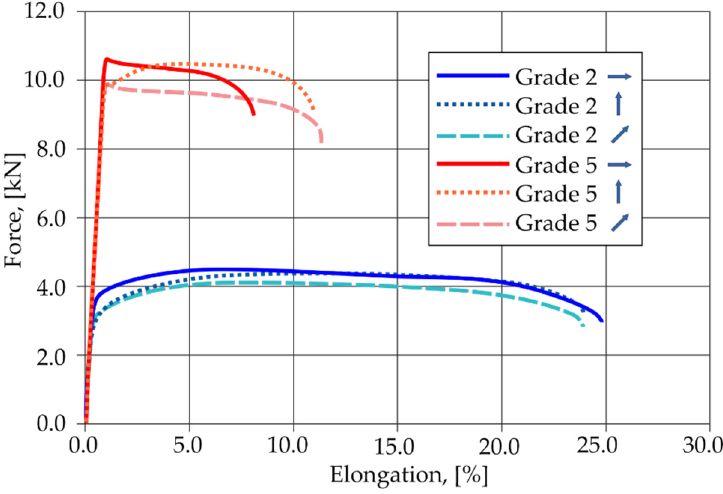
Figure 7. The method of failure of titanium samples in a tensile shear test: ( a ) with a single weld— Gr5–Gr5.1; ( b ) with two welds arranged parallel to the direction of tensile shear—Gr5–Gr5.2 and ( c ) with two welds arranged perpendicular to the direction of tensile shear—Gr5–Gr5.3.